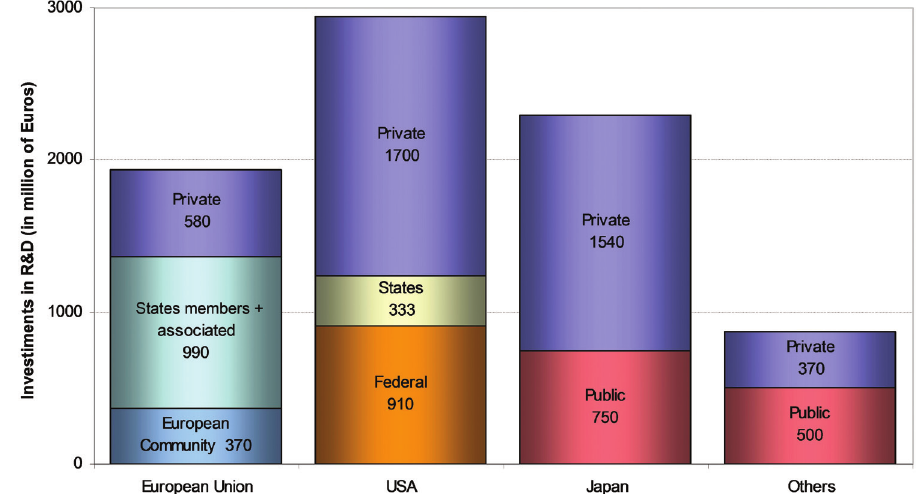
Investments in R&D (in million of